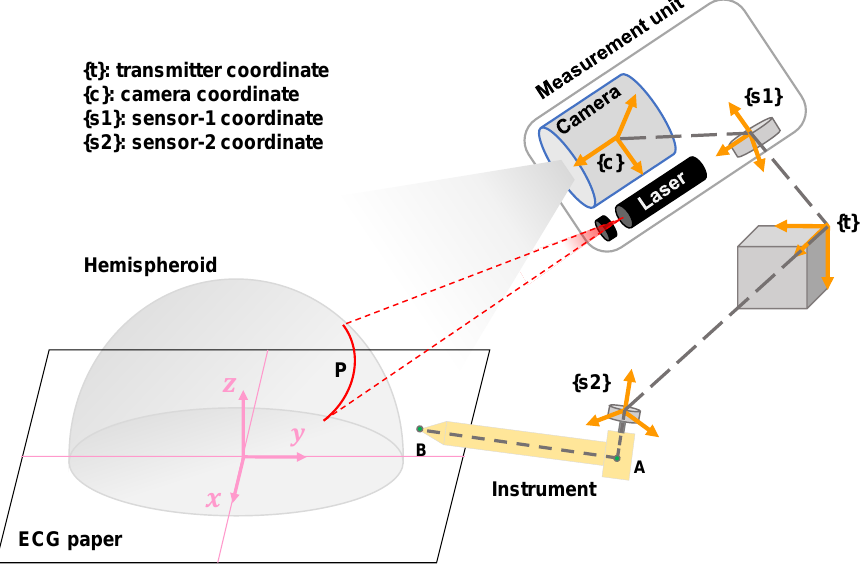
Figure 4. 3D shape measurement and pose measurement using the